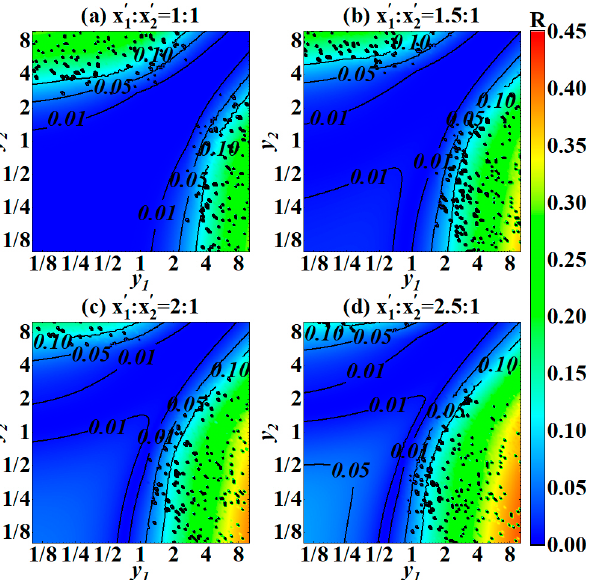
Figure 3. Distribution of the absolute value of the IA error for 1 2 / 1 = A A and different values of u = x (cid:48) 1 / x (cid:48) 2 : ( a ) x (cid:48) 1 / x (cid:48) 2 = 1:1, ( b ) x (cid:48) 1 / x (cid:48) 2 = 1.5:1, ( c ) x (cid:48) 1 / x (cid:48) 2 = 2:1, ( d ) x (cid:48) 1 / x (cid:48) 2 =